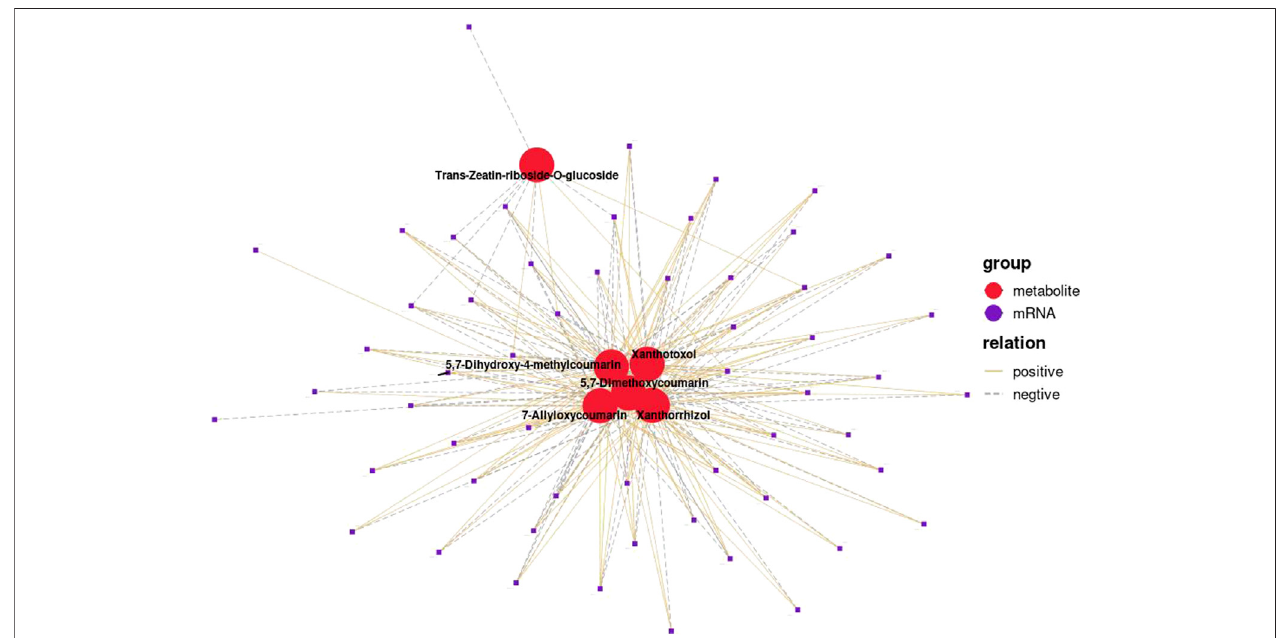
FIGURE 15 | Pearson correlation analysis of differential genes and metabolites in single-head root and double-head root ( r > 0.9, p < 0.01). Red circle represent metabolites, and purple circle represent genes. The same type of metabolite or gene is marked with the same color. The connection between genes and metabolites represents a correlation between the two, with yellow solid line representing a positive correlation and purple dotted line representing a negative correlation.